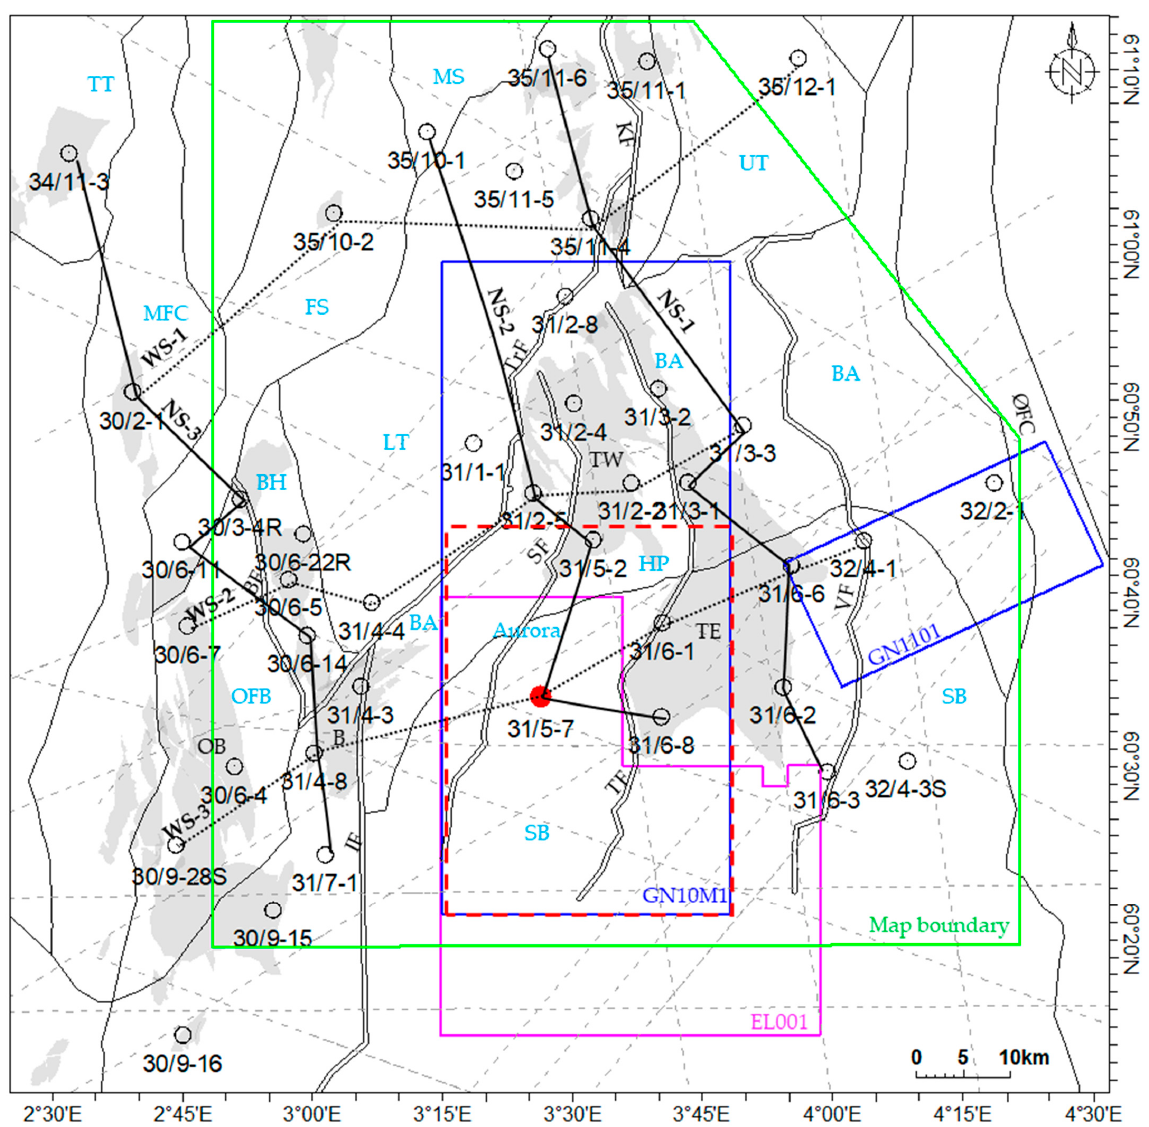
Figure 4. Map of the study area shows wells (black circles), faults (grey lines), and structural elements (e.g., BA = Bjørgvin Arch; BH = Brage Horst; FS = Flatfisk Slope; HP = Horda Platform; LT = Lomre Terrace; MS = Marflo Spur; SB = Stord Basin; TT = Tjalve Terrace; UT = Uer Terrace; Faults: BF = Brage Fault; IF = Idunn Fault; KF = Kinna Fault; MFC = Mokkurkalve Fault Complex; OFB = Oseberg Fault Block; TF = Tusse Fault; TrF = Troll Fault; ØFC = Øygarden Fault Complex). The grey shaded polygons illustrate the hydrocarbon fields and discoveries (e.g., B = Brage; OB = Oseberg; TE = Troll East; TW = Troll West) in the study area. The solid black lines (NS-1, NS-2, and NS-3) and dotted black lines (WS-1, WS-2, and WS-3) represent the well sections interpreted in the result section The boundary of the regional map is denoted in a green polygon, where the blue boundaries represent 3D seismic volume GN10M1. The cropped 3D volume (dotted red polygon) is used for Aurora site-specific evaluation. The interpreted 2D lines are denoted by the grey dashed line. The first CCS license (EL001) in offshore Norway is indicated by the violet polygon, where the red circle (31/5-7) is the proposed CO 2 injection